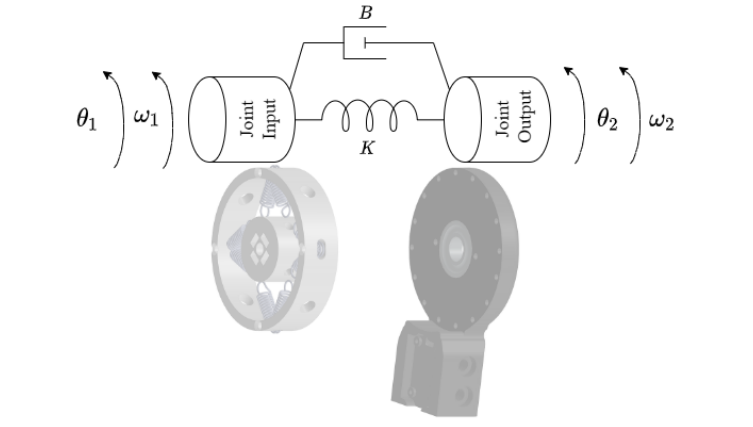
Figure 3. Joint conceptual